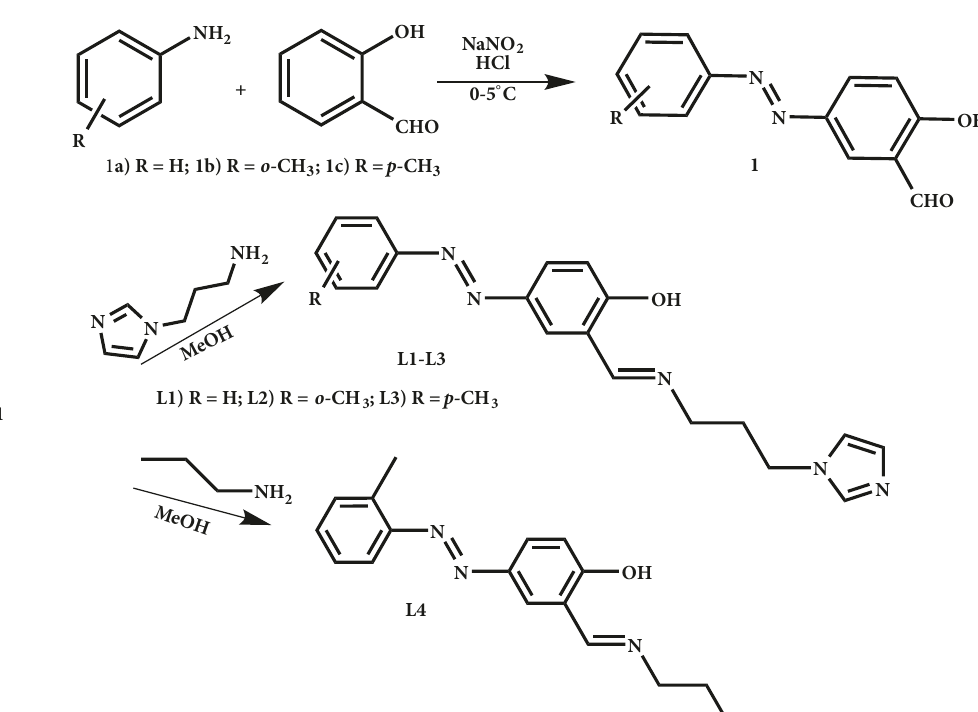
Scheme 1: Synthesis of the azo-based salicylaldehydes ( 1a-c ) and the ligands ( L1 - L4) .